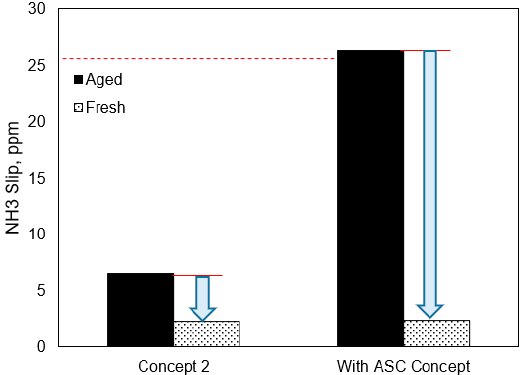
Figure 11. NH 3 slip results during NRTC with aged catalysts vs. fresh catalysts.